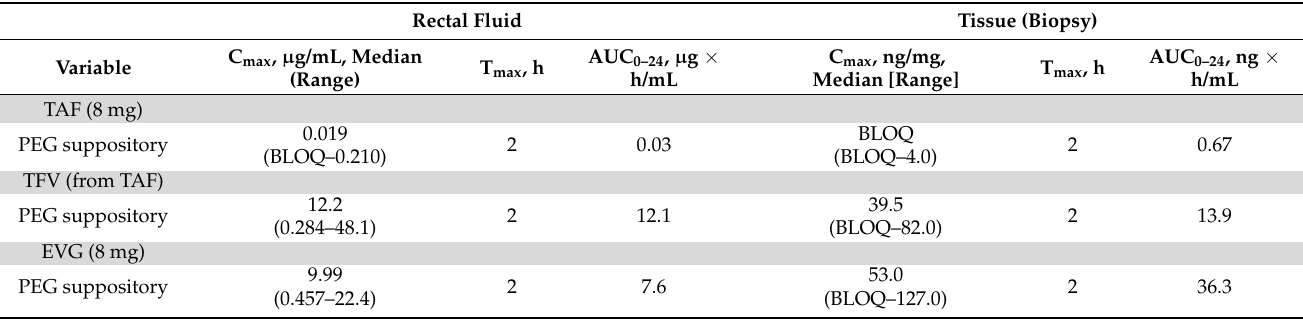
Table 3. Pharmacokinetic summary in macaques following rectal administration of PEG-based suppositories containing TAF/EVG (8 mg/8 mg).